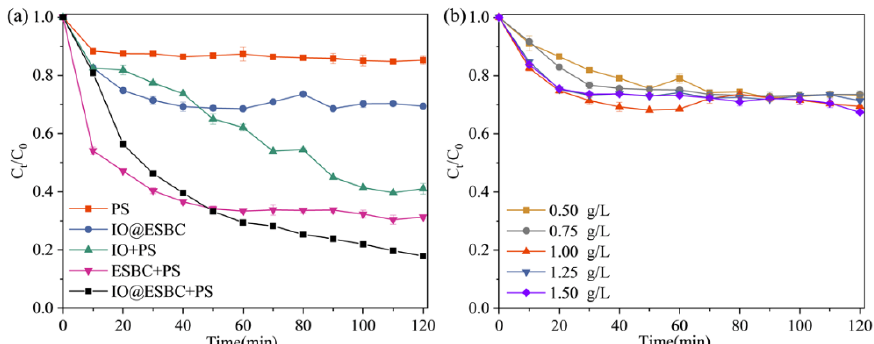
Figure 2. ( a ) TCH degradation by different systems; ( b ) Adsorption performance of TCH under different dosage of IO@ESBC. Experimental conditions: the original PS concentration of 10 mM, TCH dosage of 50 mg/L, IO@ESBC dosage of 1.25 g/L, IO dosage of 1.25 g/L, initial pH, and temperature of 25 °C.